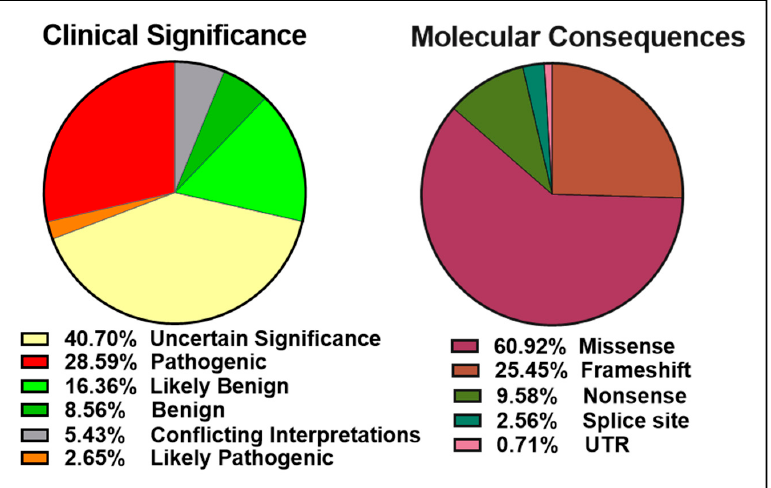
Figure 3. Pie charts representing the percentages of BRCA2 germline and somatic variants grouped into clinical significance (left) or molecular consequences (right) as reported in the ClinVar database (https://www.ncbi.nlm.nih.gov/clinvar/?term=BRCA2%5Bgene%5D, accessed on 10 April 2021).